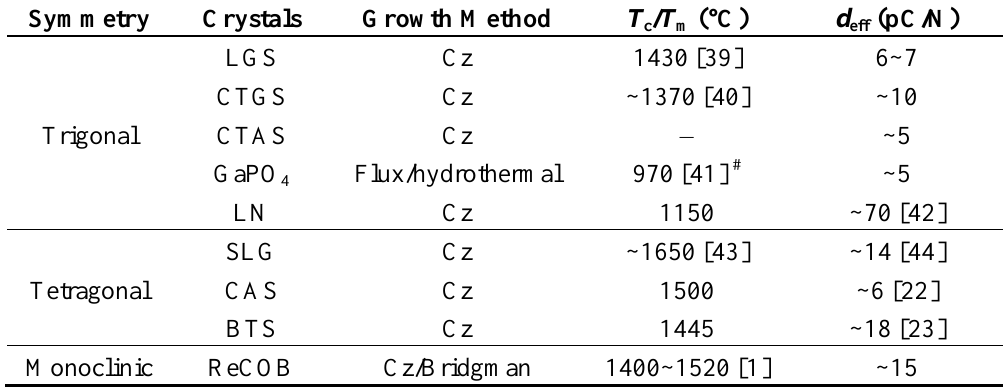
Table 1. A comparison of different high temperature piezoelectric crystals. LGS, La Ga SiO ; CTGS, Ca 3 5 14